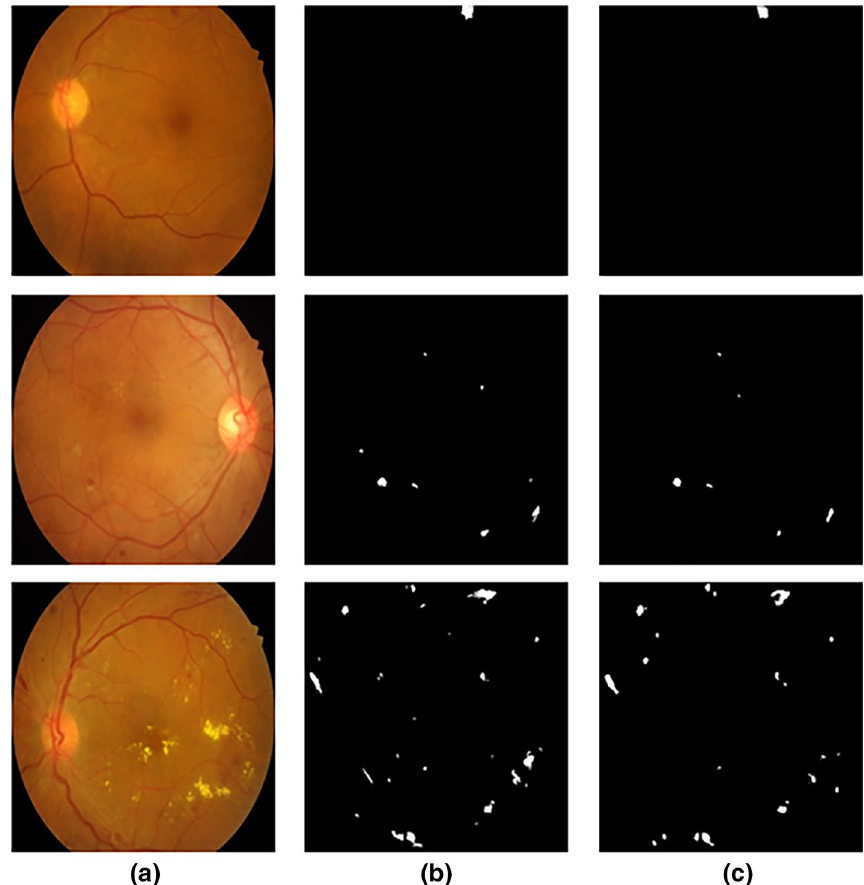
Fig. 14 Results of hemorrhages segmentation: a original image, b hemorrhages label and c segmented